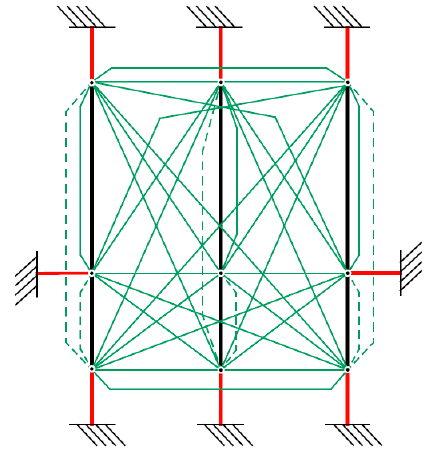
Figure 3. All types of constraints for the 3-PG (planetary gear) set.